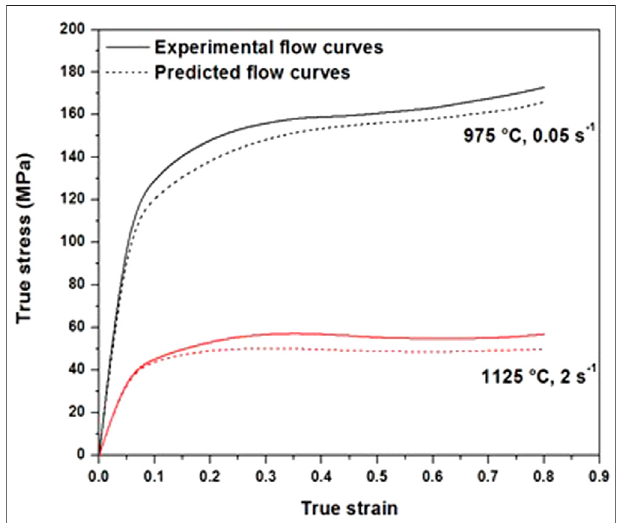
FIGURE 3 | Comparison of predicted and experimental fl ow curves.